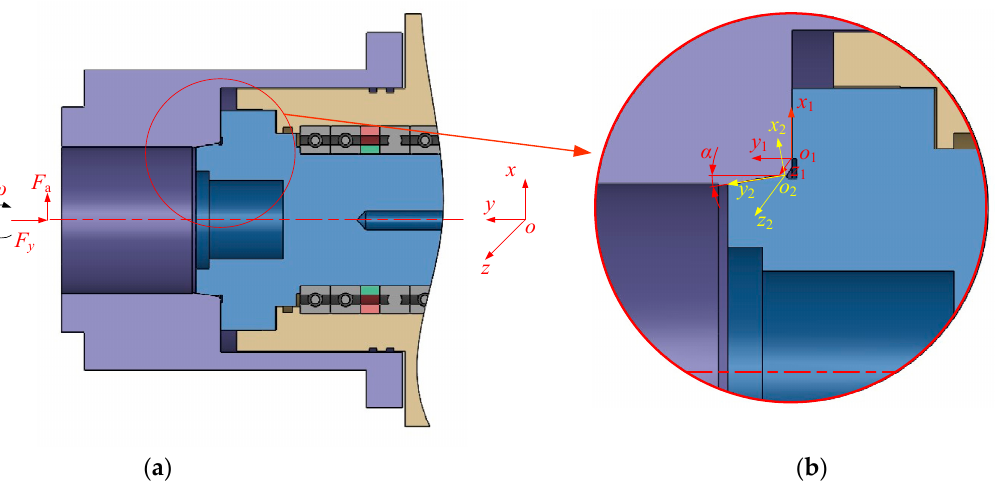
Figure 2. Applied load and coordinate system of the spindle–GWF: ( a ) applied load of the GWF; ( b ) local coordinate system of the spindle–GWF